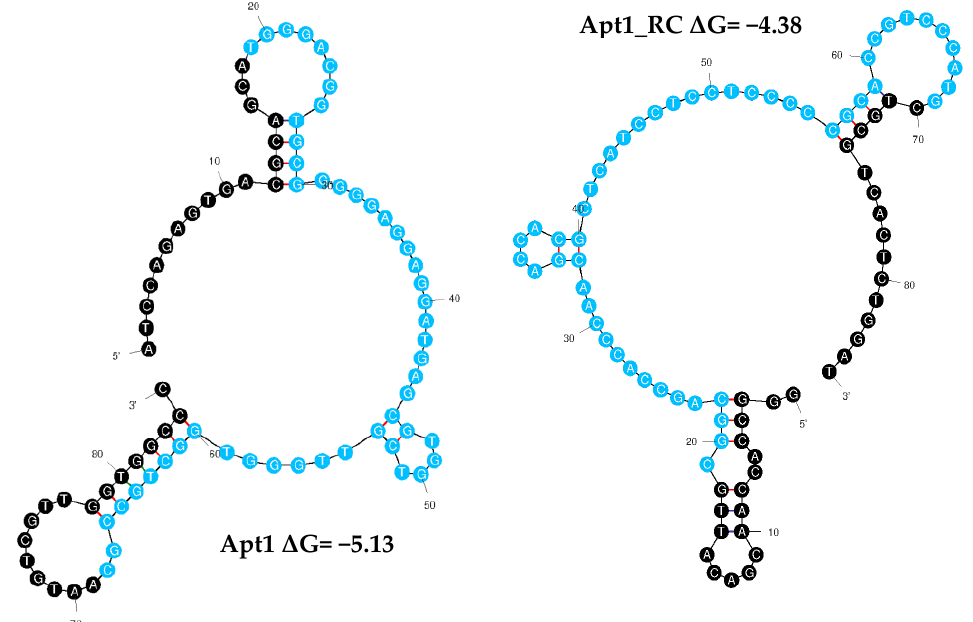
Figure 3. Secondary structures of finalized candidate aptamer sequences obtained from cell-SELEX. The Mfold web server was used to predict the secondary structures of Apt1 and Apt1_RC selected for in vitro characterization. To calculate the Gibbs free energy of the aptamer sequences, the constant primer regions were considered at 37 ◦ C, 187 mM Na + and 1.4 mM Mg 2+ . Random and primer regions are presented in blue and black,